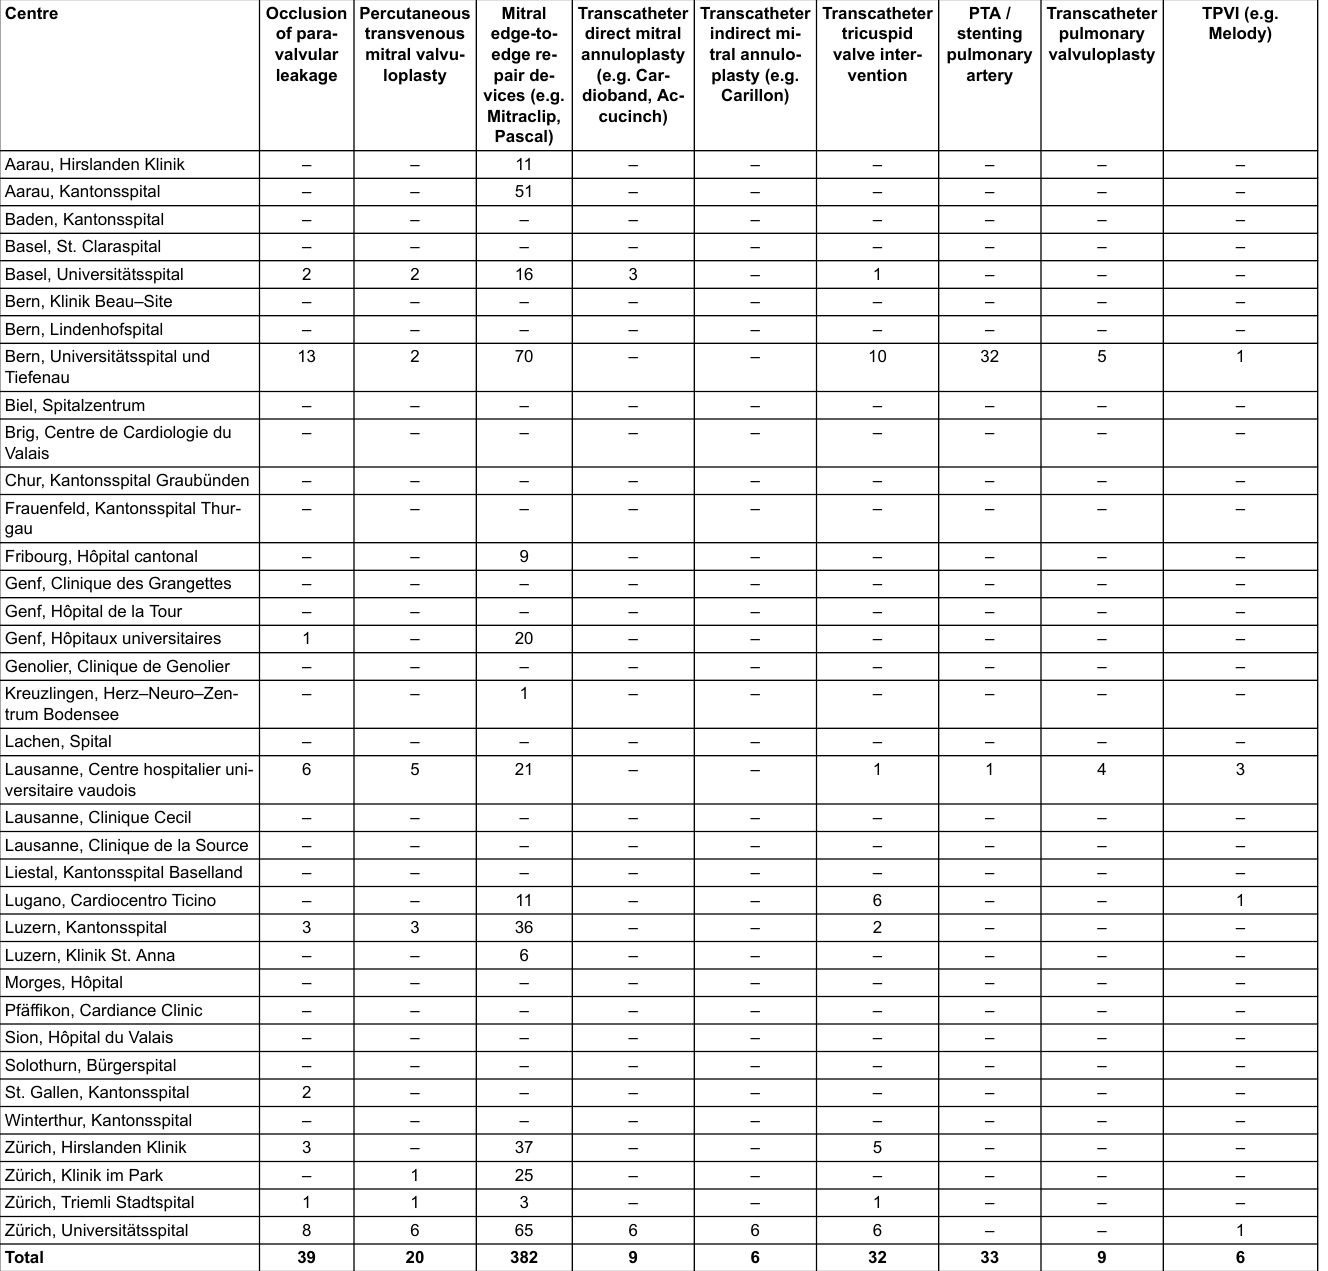
Table 6: a: Structural interventions: other.